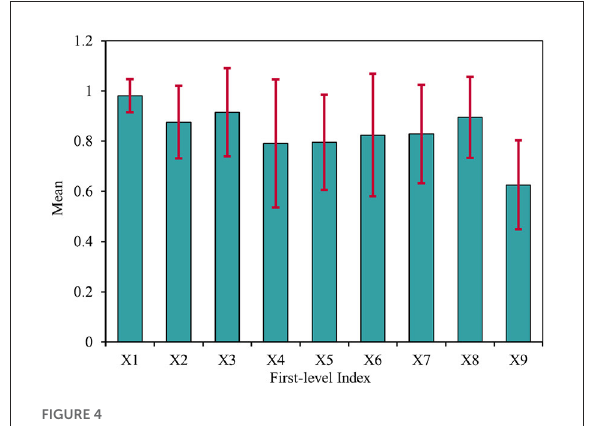
FIGURE4 The mean values of nine first-level